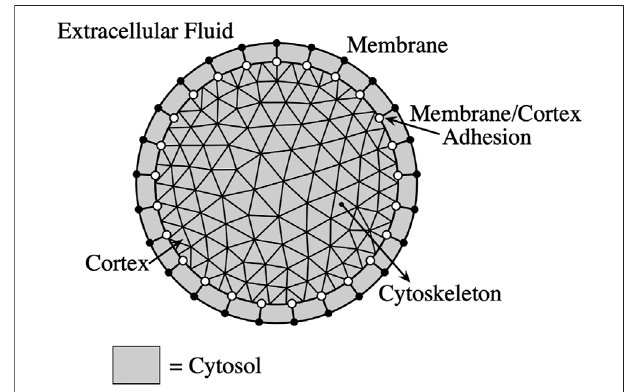
FIGURE 1 | Bleb model schematic. Circles indicate the discretized membrane and cortex. The triangular grid represents the discretized cytoskeletal network (cortex/cytoskeletal adhesion not